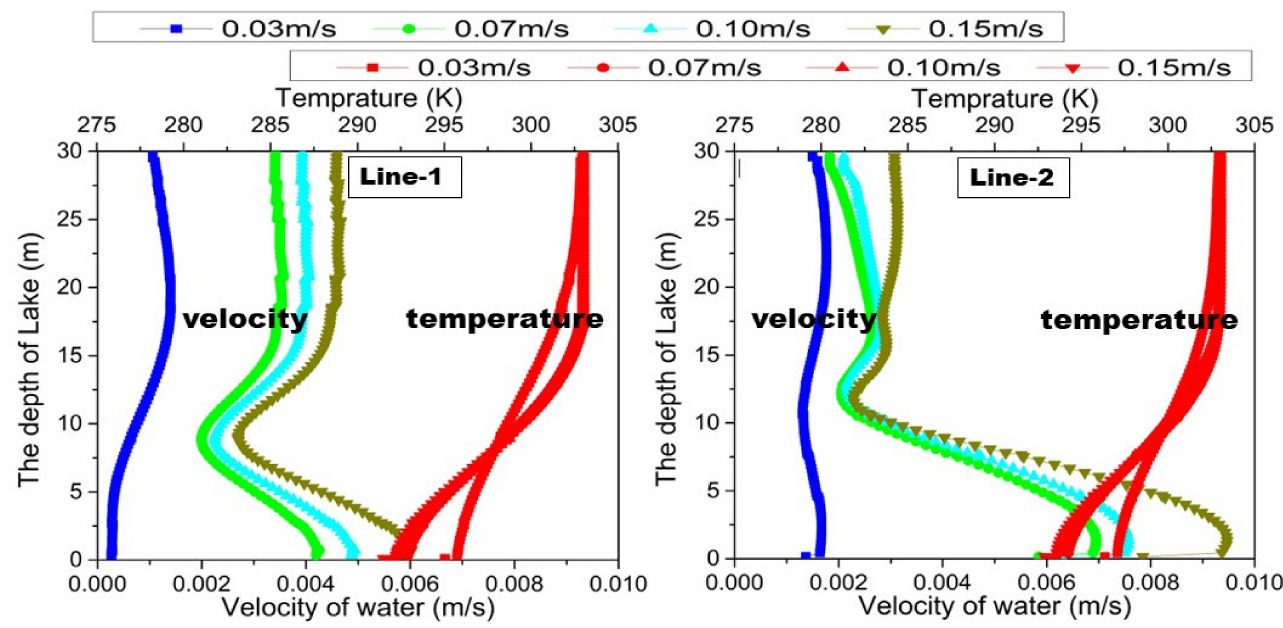
Figure 7. Vertical distribution of water temperature and velocity with different gas inlet velocities in Line 1 and Line 2 under 4mG-Lift.